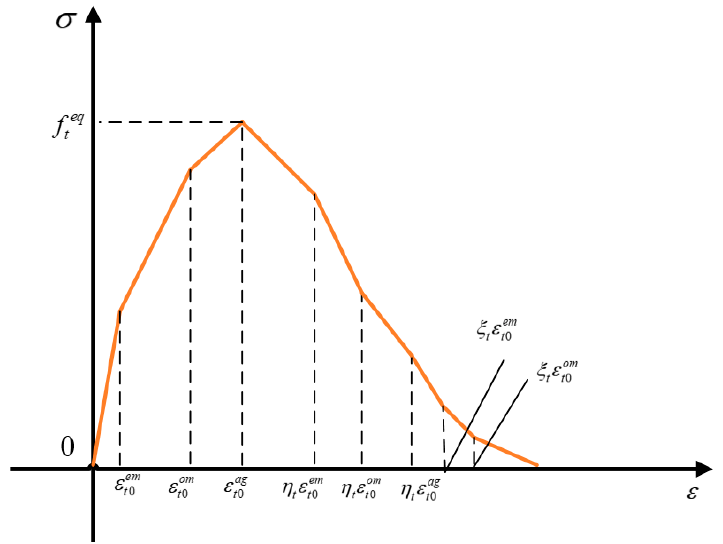
Figure 6. Mean stress/mean strain and damage curves under homogeneous equivalent tensile treatment.